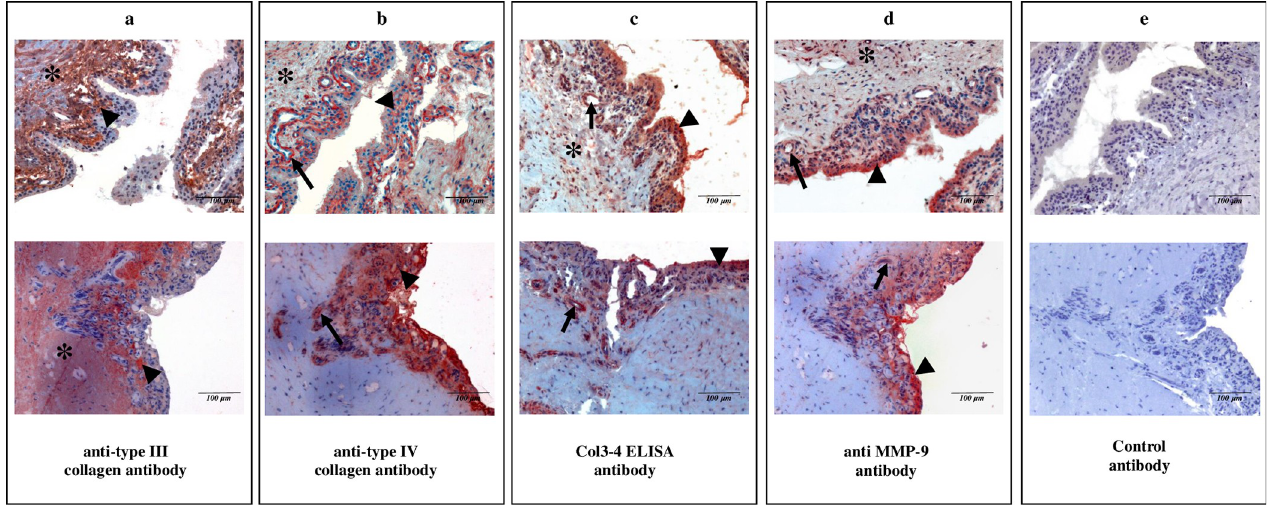
Fig 3. Immunohistochemistry of synovial tissue from a patient with RA. a) Staining of subintimal synovium (asterisk) and deeper area of cell lining layer (arrowheads) with anti-type III collagen antibody; b) staining of synovial intima (arrowheads), underlying vessels (arrows) and sub-intima (asterisk) with anti- type IV collagen antibody; c) staining of synovial intima (arrowheads), underlying vessels (arrows) and sub-intima (asterisk) with the polyclonal antibody used in the Col3-4 ELISA; d) staining of synovial intima (arrowhead), underlying vessels (arrows) and sub-intima (asterisk) with anti MMP-9 antibody; e) immunohistochemistry performed with rabbit IgG isotype